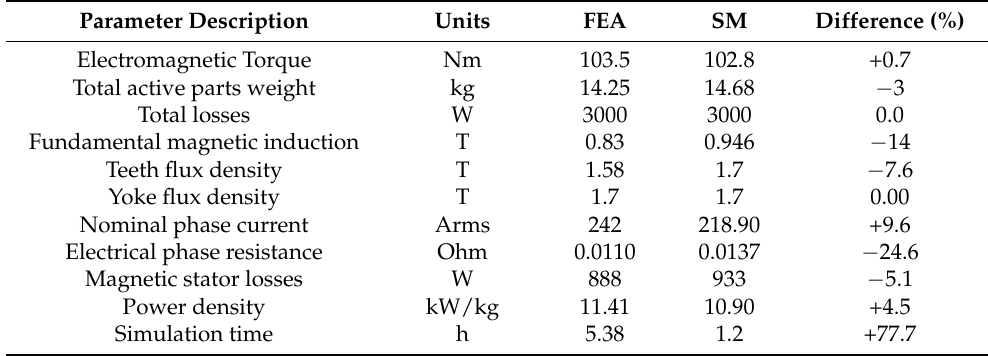
Table 12. Comparison of the optimal results found by the space mapping and optimization direct